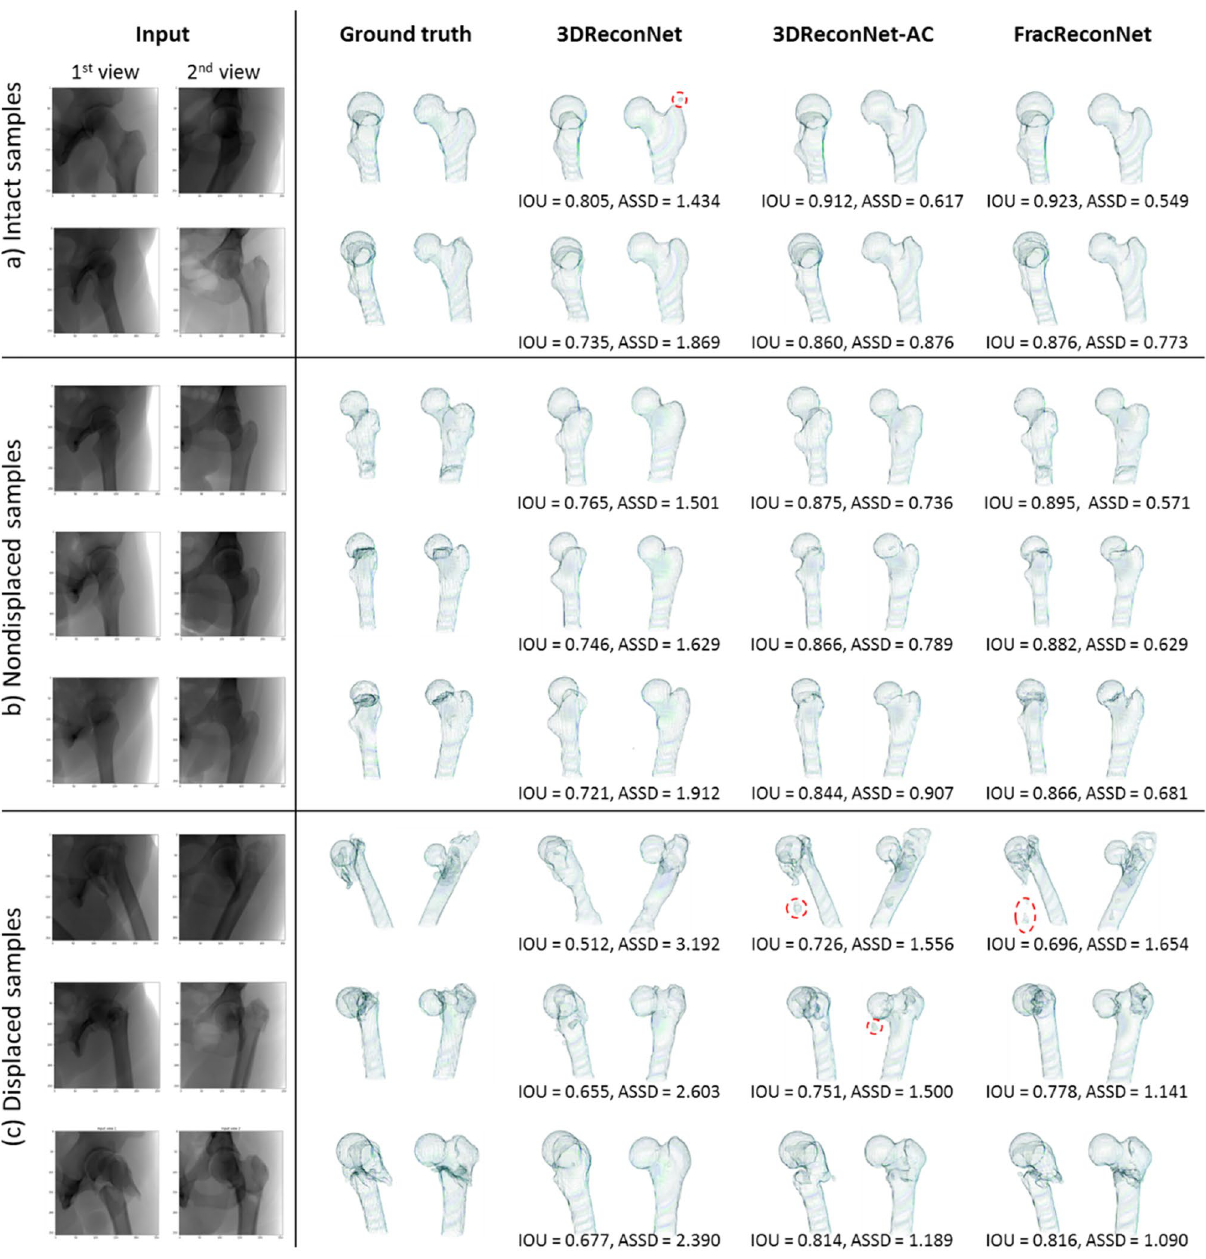
circles in the figure indicate bulky noise occurring in the reconstructed